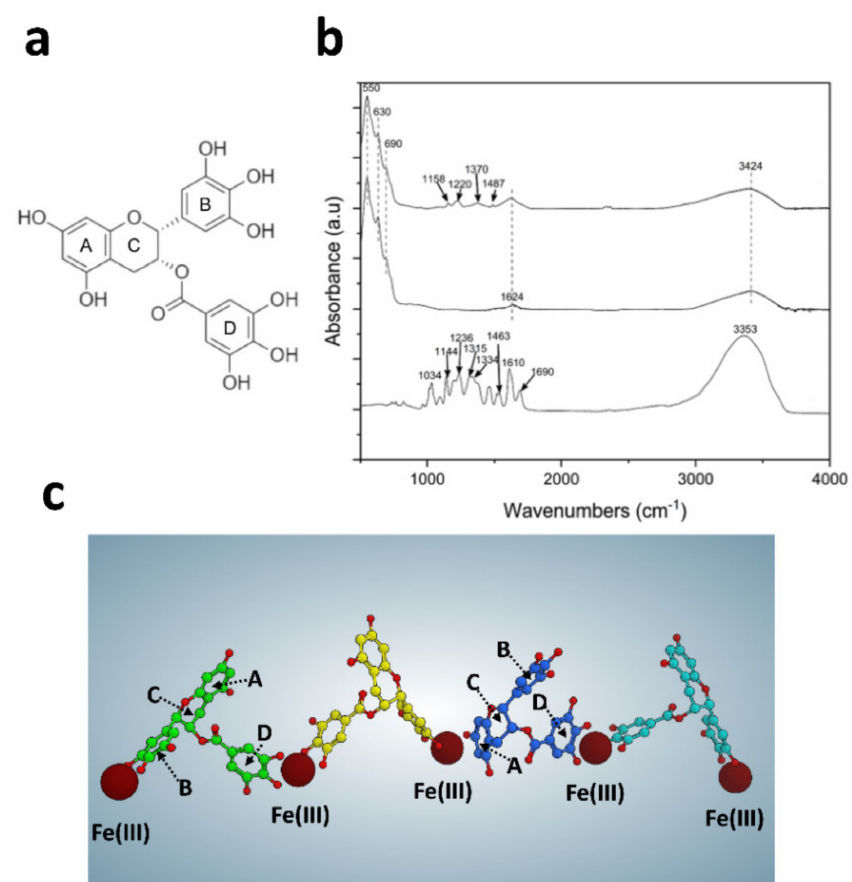
Figure 2. EGCG interaction with the SAMN surface. ( a ) Molecular structure of EGCG. ( b ) FT-IR spectra of bare SAMNs, the SAMN@EGCG nanohybrid, and EGCG from top to bottom, respectively. ( c ) Exemplary representation of iron(III) EGCG complexes obtained from MD simulation. The coordination between iron(III) and EGCG B- and D- rings (green, yellow, cyan), as well as EGCG A- and D- rings (blue), is